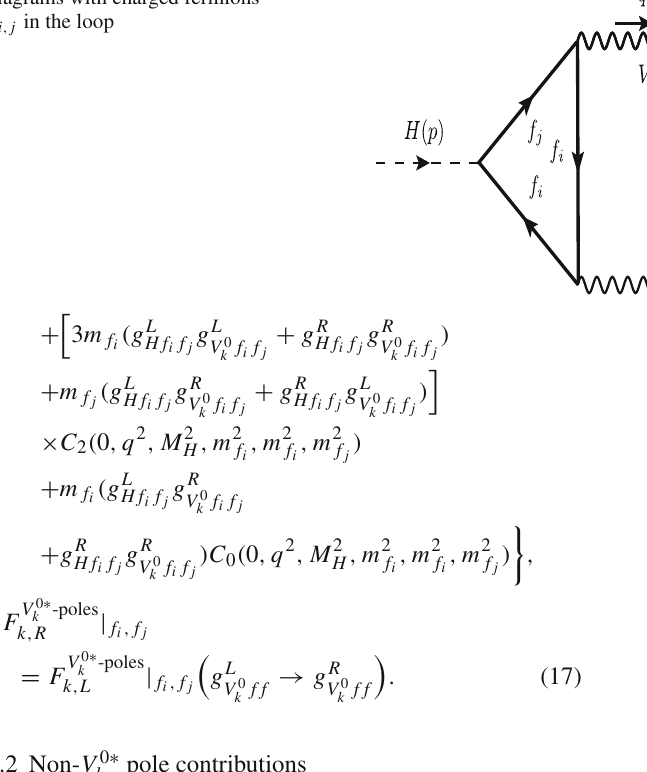
Fig. 6 One-loop triangle diagrams with charged fermions f i , j in the